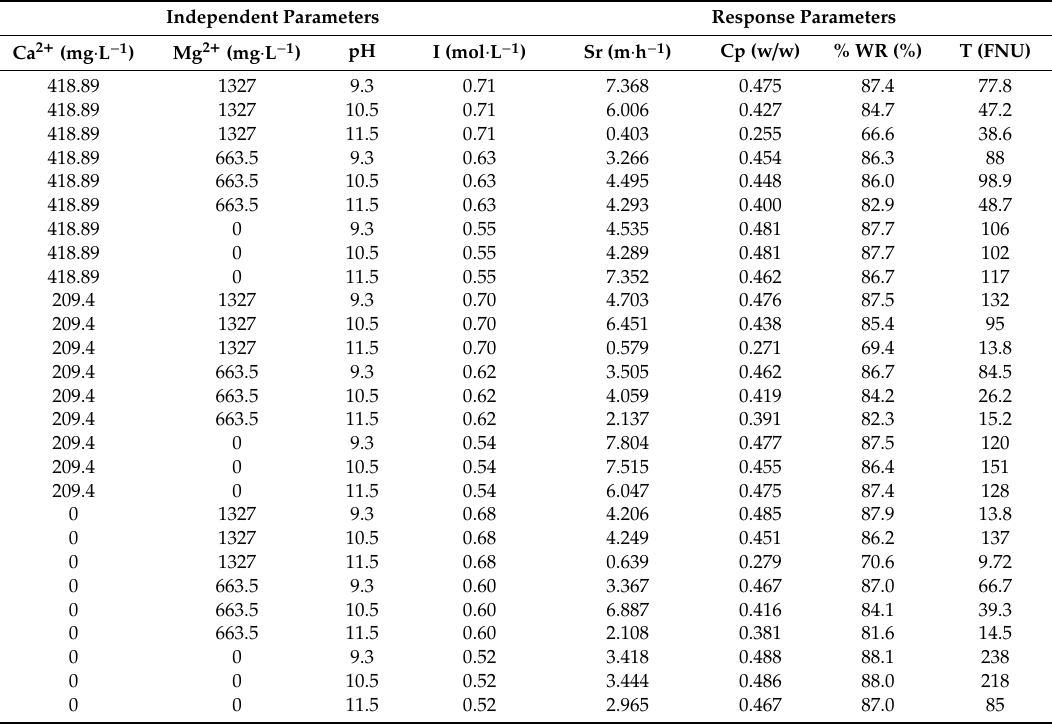
Table 4. Results of sedimentation tests in